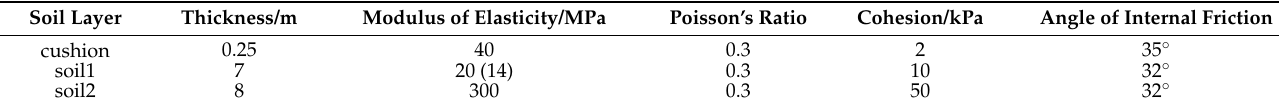
Table 4. Mechanical parameters of soil